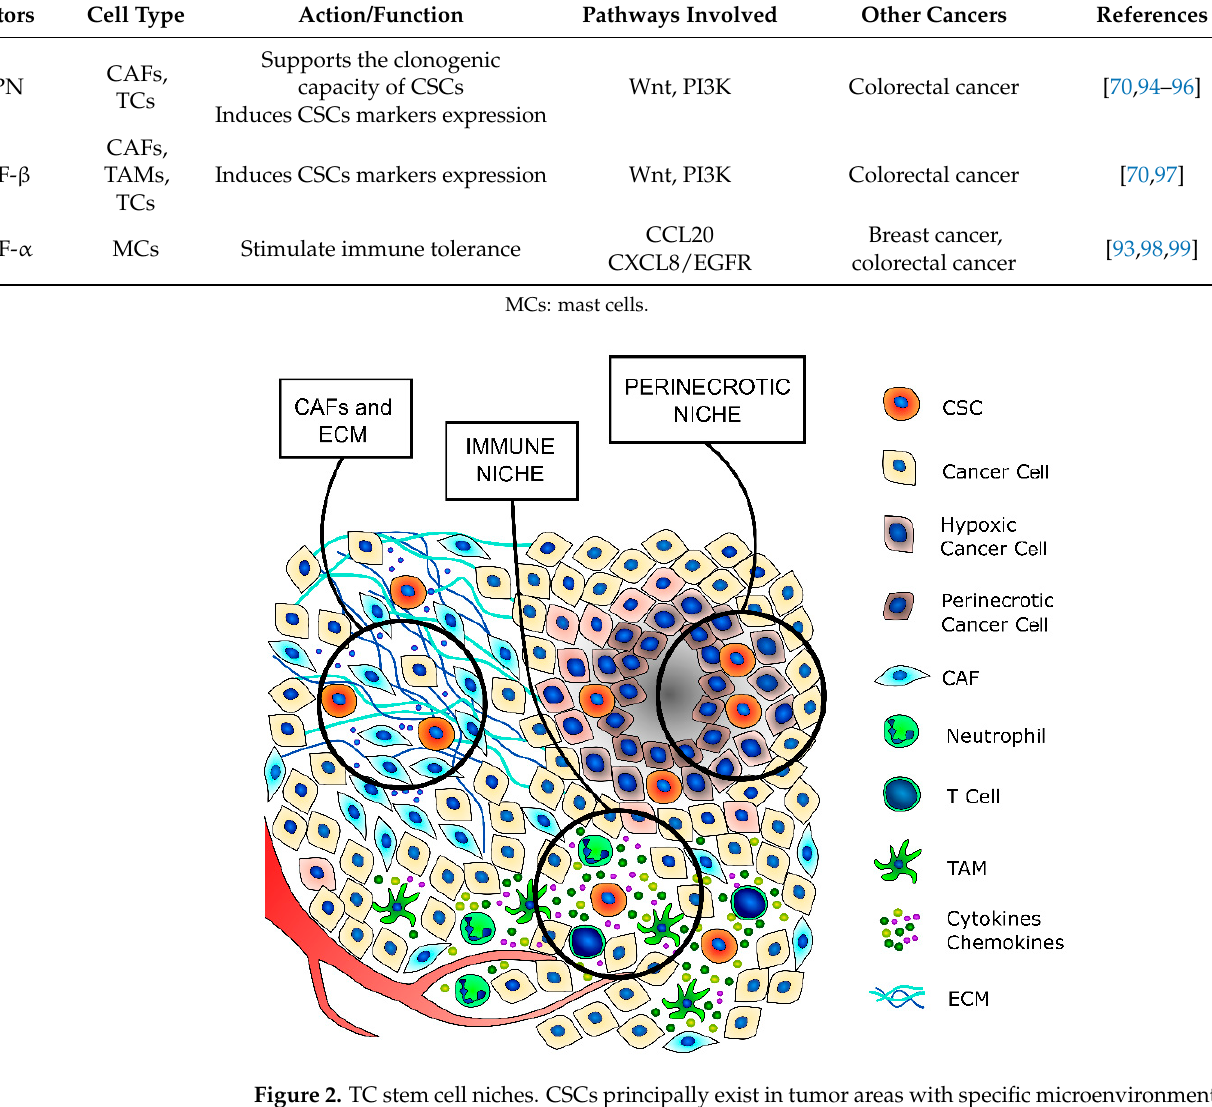
Table 2. Secreted factors that promote CSCs’ phenotypes and survival.